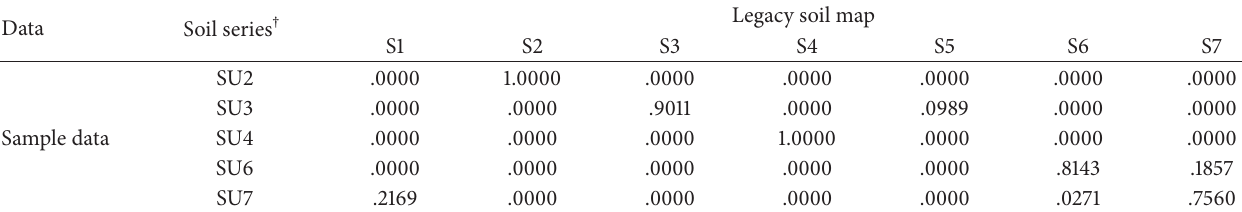
Table 1: Cross-field transition probability matrix from sample data (5 soil series) to colocated data in the legacy soil map (7 soil series). Data